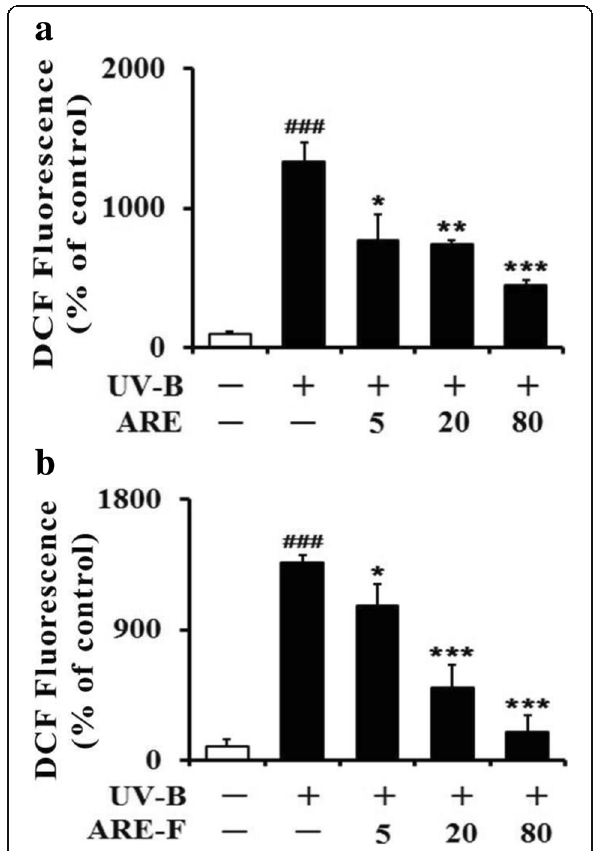
Fig. 1 Suppressive effects of ARE, ( a ) and ARE-F ( b ) on the ROS levels in HaCaT keratinocytes under UV-B irradiation. HaCaT cells were subjected to the varying concentrations (0, 5, 20 and 80 μ g/mL) of ARE ( a ) and ARE-F ( b ) for 1 h before the irradiation. The ROS levels were determined using DCFH-DA in a microplate fluorometer, and represented as DCF fluorescence, expressed as a percentage (%) of the corresponding non-irradiated control. ### P <0.001 versus the non-irradiated control. * P <0.05; ** P <0.01; *** P <0.001 versus the non-treated control (UV-B irradiation